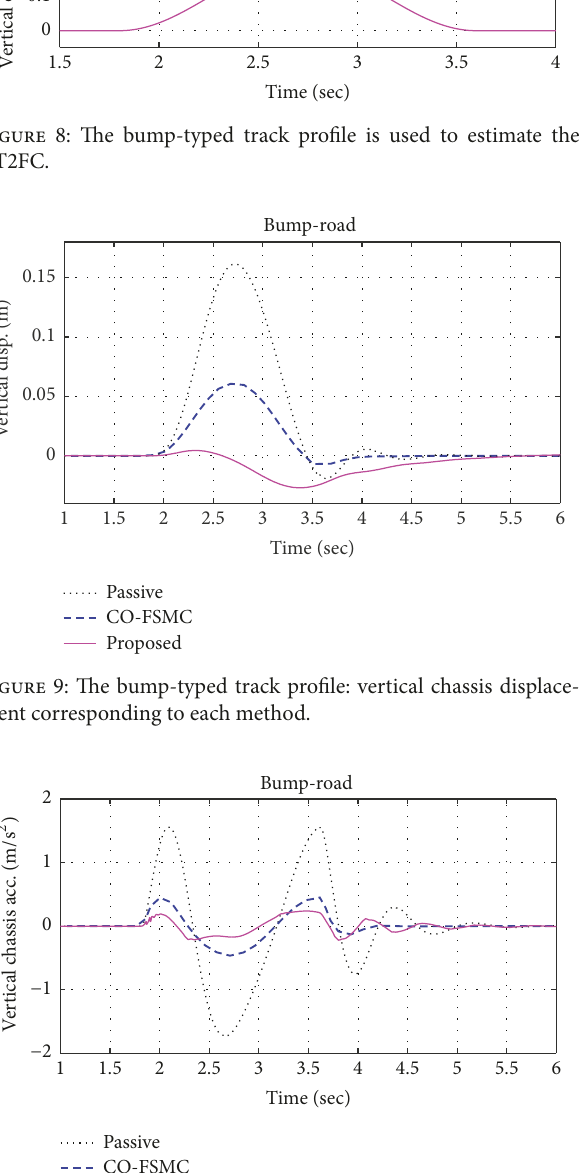
Table 4: The sine-typed track profile: vertical chassis displacement and